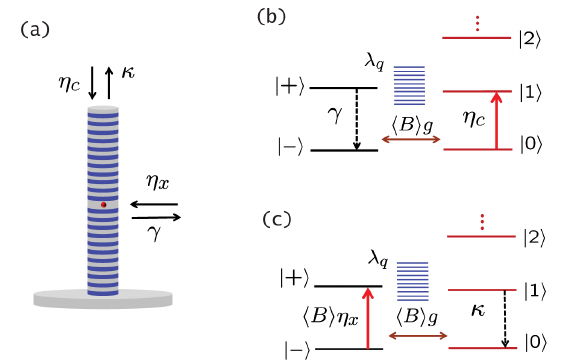
FIG. 1. (a) Schematic of an example of a semiconductor cavity used in cavity-QED (micropillar system), containing a coupled , from the side, or (cid:4) , from the QD, and driven by a cw laser ( (cid:4) x c top). The micropillar system is advantageous to study PL power broadening since, e.g., exciton broadening can be directly studied through cavity emission—since these input-output channels are geometrically decoupled. (b) Schematic of a cavity-driven cavity- QED system, where jþi denotes the excited QD state, j(cid:1)i denotes the ground state, j 1 i and j 0 i represent the first excited and ground state of the cavity mode. Also shown is the phonon reservoir represent a as blue (multiple) lines. The terms h B i g and h B i (cid:4) x phonon-modified coherent reduction ( h B ið T Þ (cid:5) 1 ) in the exciton- cavity coupling rate and the exciton pump rate, respectively, (see text for details). (c) Schematic of a dot-driven cavity-QED system with same energy-level notation as in